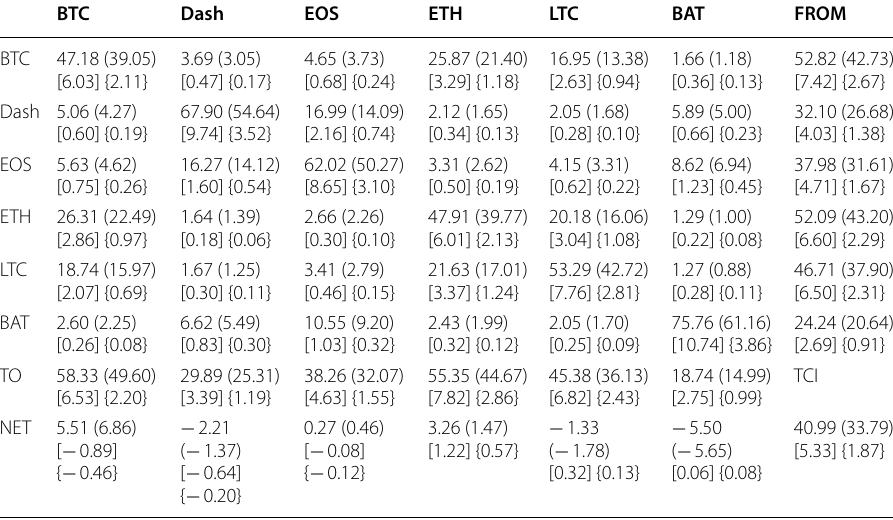
The values in parentheses (), square brackets [], and curly brace {} denote the short‑term (1–5 days), medium‑term (5–22 days), and long‑term (more than 22 days) frequency connectedness